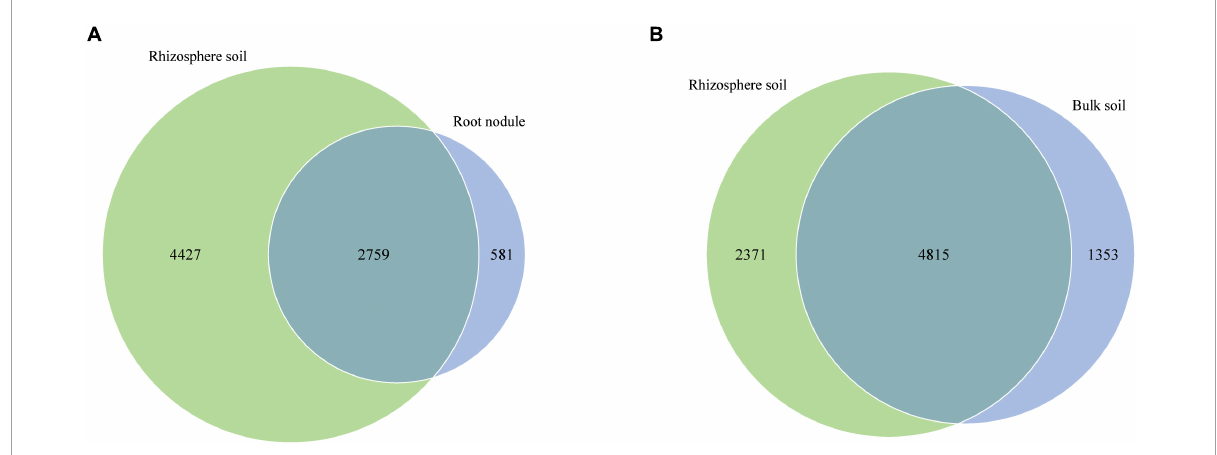
FIGURE4 Venn diagrams show the number of shared and unique OTUs in different nodules and soil samples. (A) is shared and unique OTUs between nodules and rhizosphere soils. (B) is shared and unique OTUs between rhizosphere soil and bulk